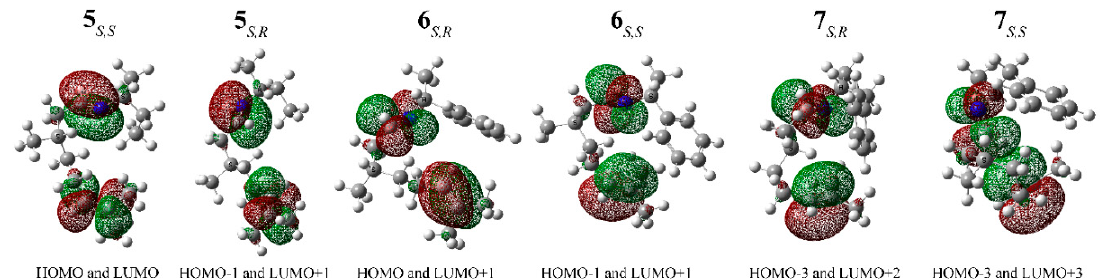
Figure 8. Interactions of the molecular orbitals of all the diastereoisomers of imines 5, 6, and 7.